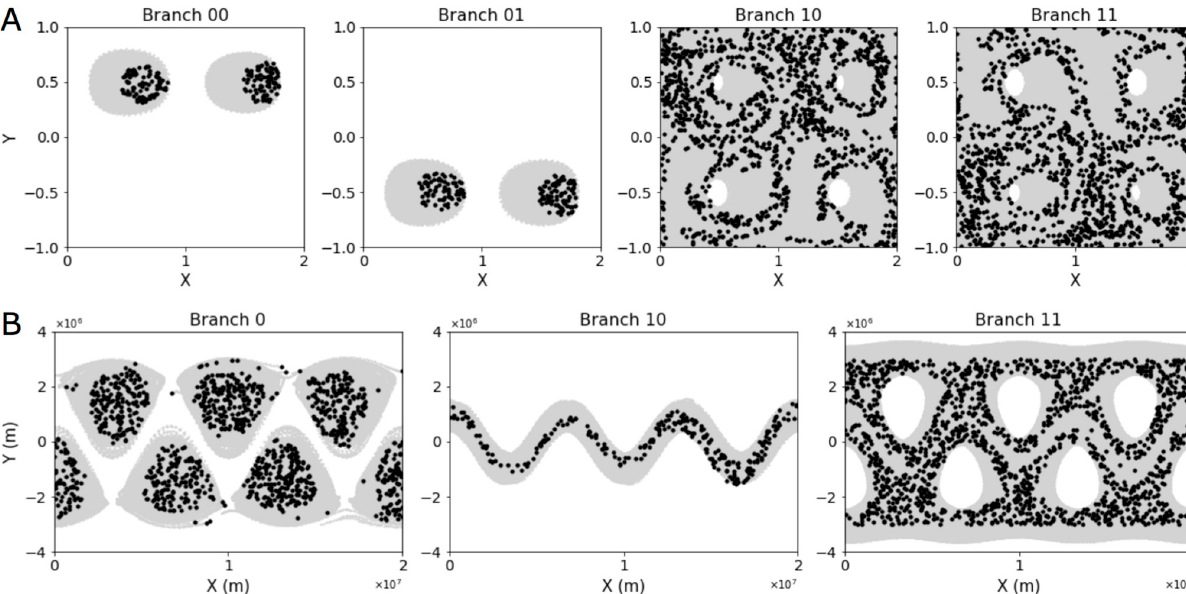
Fig 3. Selected coherent structures from the quadruple-eddy and Bickley jet. (A) Four selected branches from the quadruple-eddy analysis are visualized by plotting the particle trajectories belonging to a designated coherent structure (gray) and their starting positions (black). Branches 00 and 01 show the top and bottom eddy cores, respectively, whereas branches 10 and 11 show the incoherent region. The latter two branches also display an imbalance between the top and bottom regions of the flow. (B) Three selected branches from the Bickley jet analysis are visualized by plotting the particle trajectories belonging to a designated coherent structure (gray) and their starting positions (black). Branch 0 shows the eddy cores, which do not mix. Branch 10 contains the meandering jet, and branch 11 accounts for the incoherent surroundings. For both sets of plots, the starting positions show that the particles belonging to coherent structures at a given time point (in this case, the starting point) are more compactly located than the total space explored by their trajectories over time. A particle found at a given instant in the space that is common among different coherent structures can therefore not be attributed to a coherent structure based on that time point alone. Visually equivalent results can be produced from other time points.